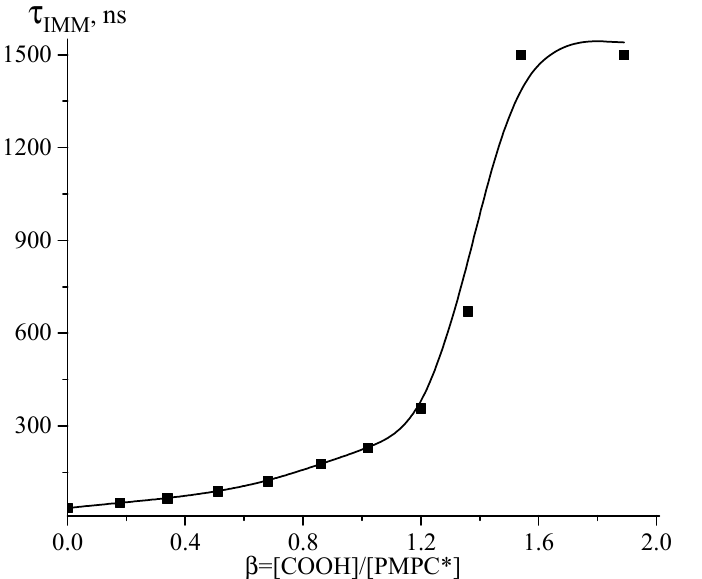
Figure 3. Dependence of τ IMM of PMPC* on the ratio β = [COOH]/[PMPC]* upon addition of a solution of “dark” PMAA.